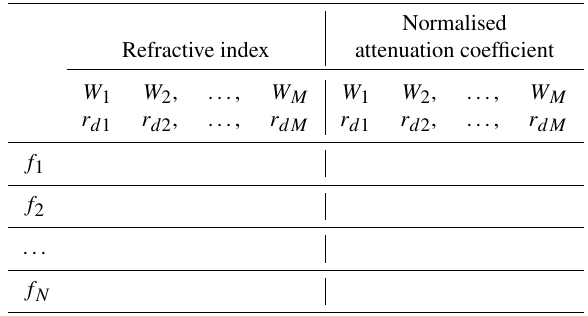
Table 3. Presentation of measurement data of the refractive index and normalised attenuation coefficient in a worksheet of the Excel